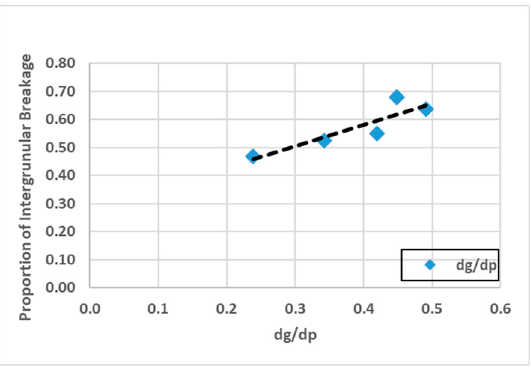
Figure 10. Increasing the proportion of intergranular breakage by increasing the grain size to particle size ratio (dg/dp).